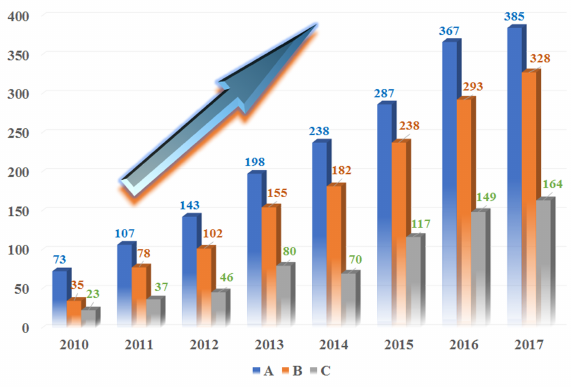
Figure 2: Comparison of the annual number of scientific publica- tions focus on the halloysite from 2010 to 2017 (Data analysis of publications was done using the Web of Science search system. Section A represents the publication numbers with the term “hal- loysite”; Section B represents the publication numbers with the term “halloysite” and “nanotube”; Section C represents the publica- tion numbers with the term “halloysite” and “polymer”)